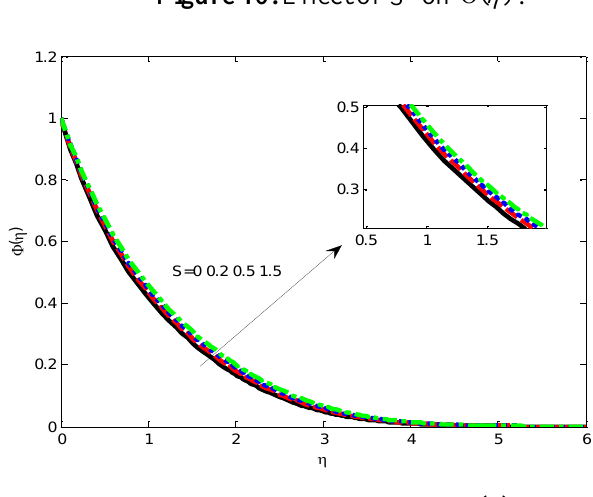
Figure 10. Effect of S on ( )  .